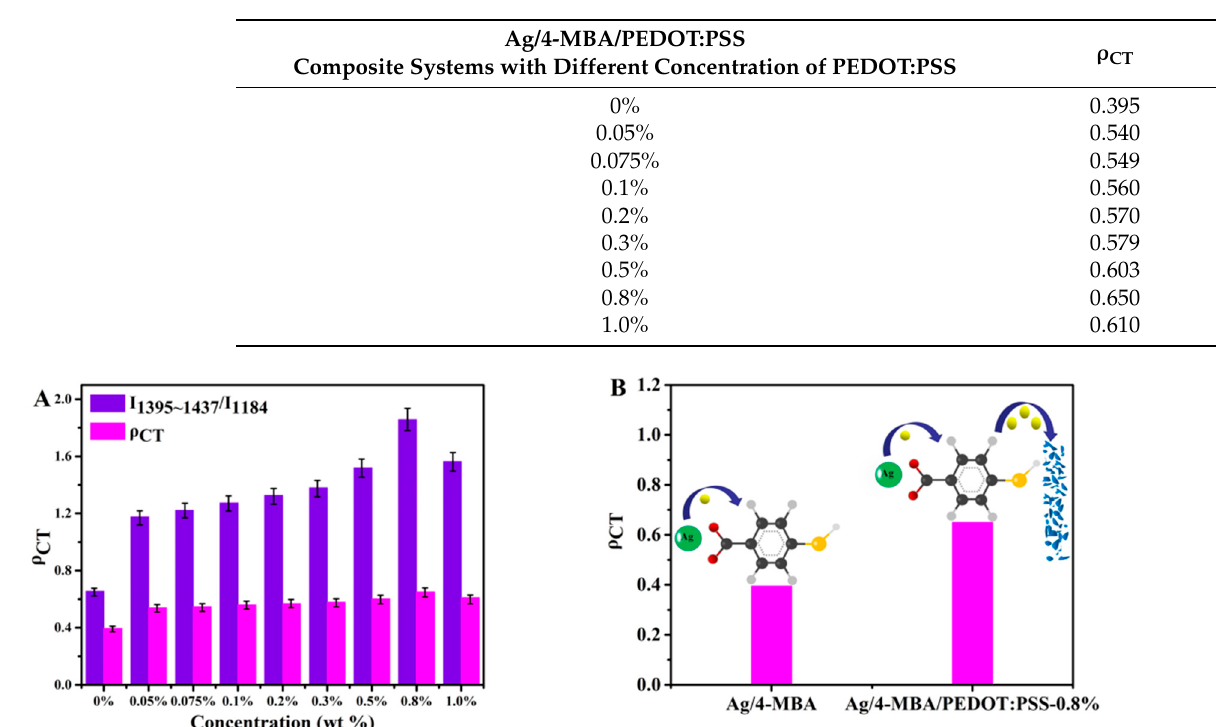
Table 2. ρ CT values of Ag/4-MBA/PEDOT:PSS systems with different PEDOT:PSS concentrations. Ag/4-MBA/PEDOT:PSS